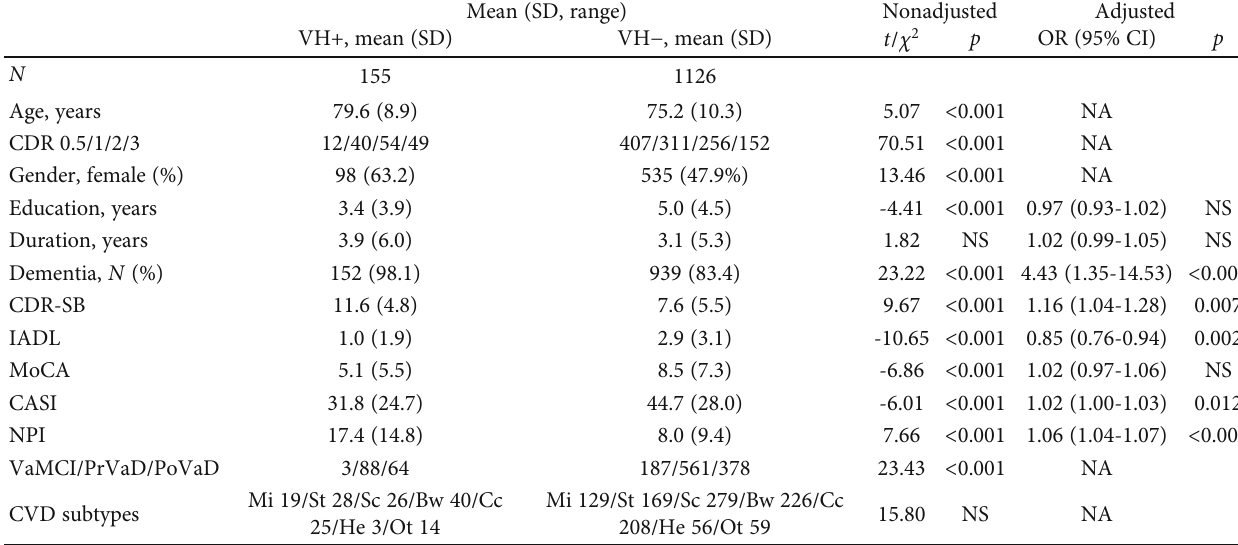
Table 1: Demographic and background characteristics of VCI patients with or without visual hallucinations (VHs) adjusted for age, gender, and disease severity by